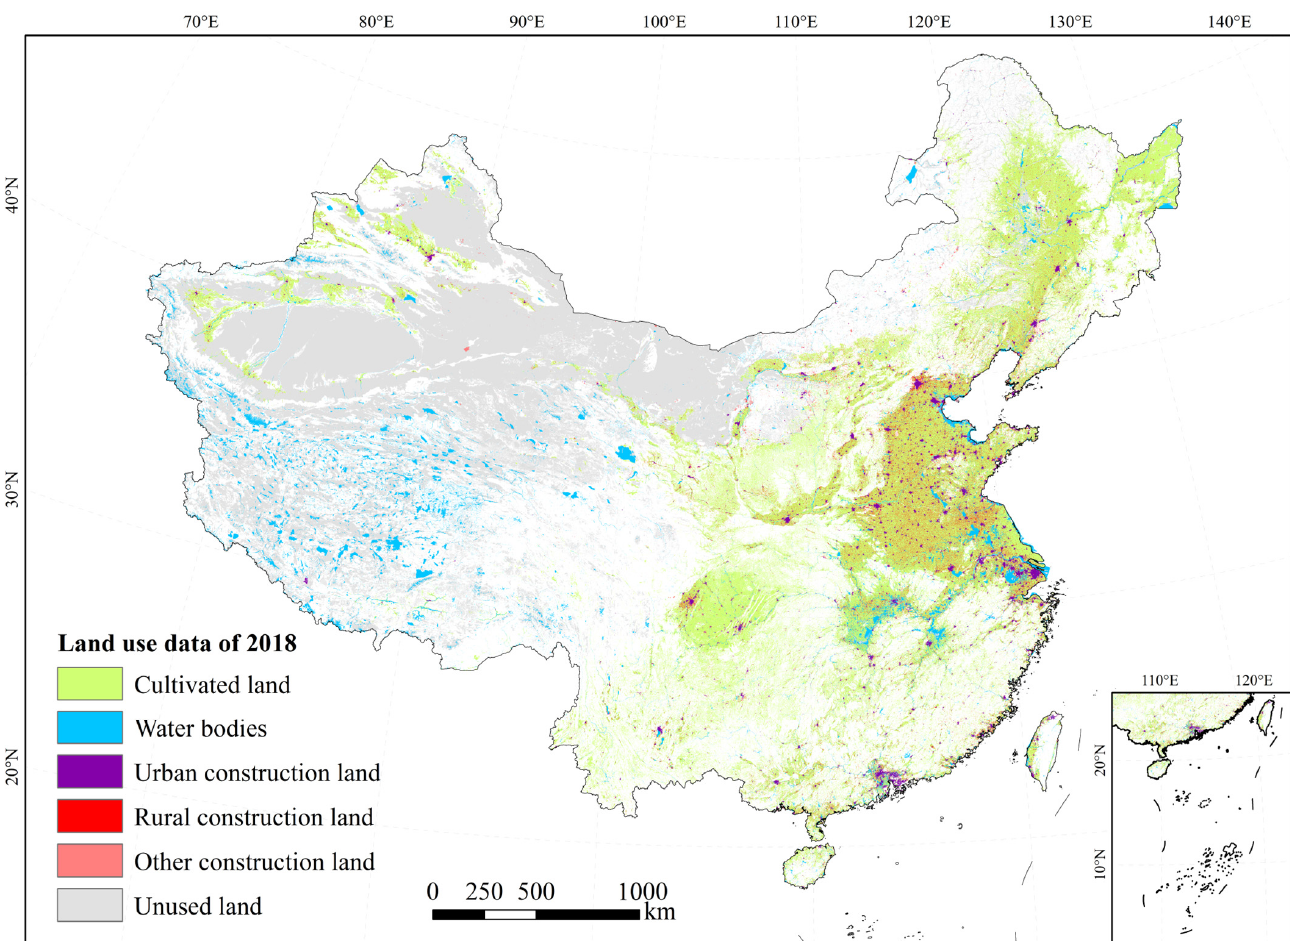
Figure 3. Land use data for 2018. The land use classes used in this study are cultivated land, water bodies, unused land, and three types of construction land, i.e., urban construction land, rural construction land, and other construction land. Other classes are labeled as colorless.